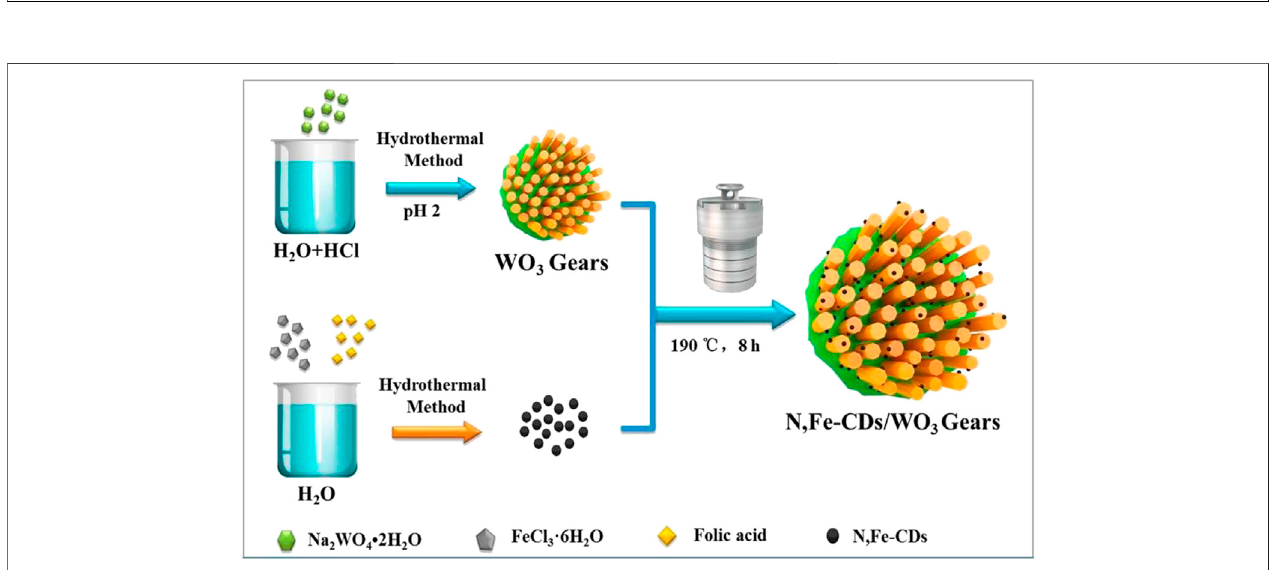
SCHEME 2 | A schematic illustration of the fabrication of the gear-shaped WO3 (G-WO3) and N, Fe-CDs/G-WO3. (Reproduced from Ni et al., 2020, MDPI).